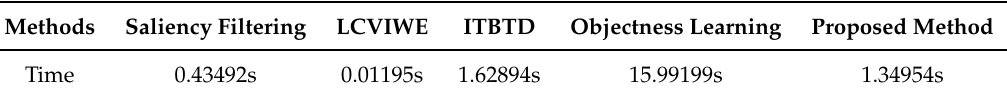
Table 4. Comparison of average computational time for the proposed method and the state-of-the-art